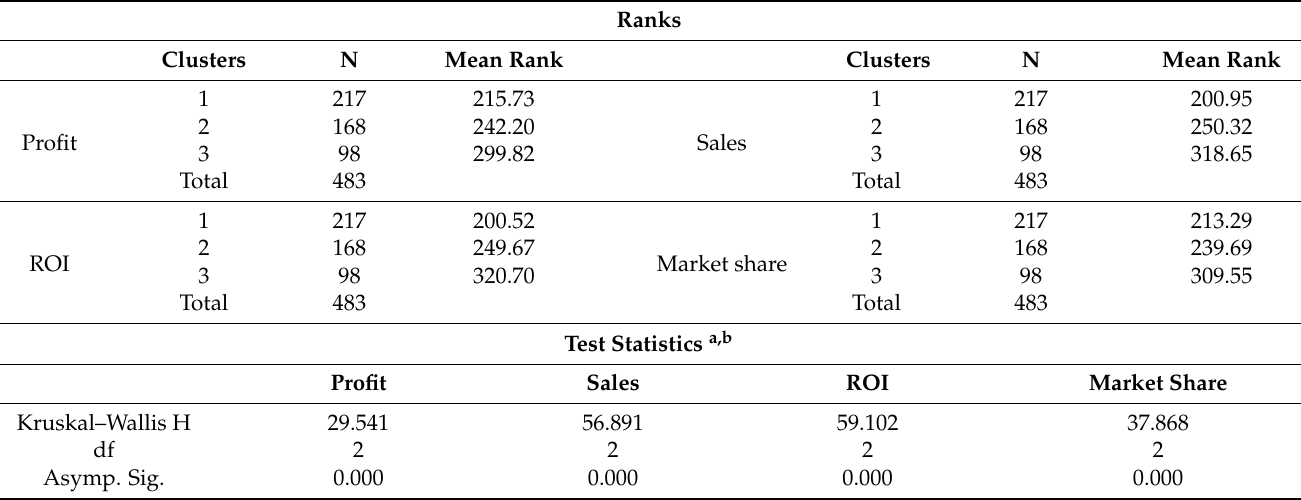
Table 5. Results of Kruskal–Wallis H